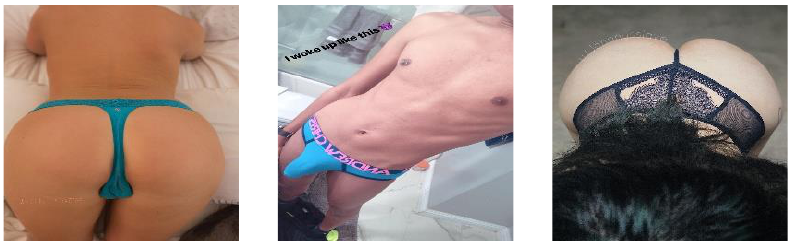
Figure 1. Some example sexy images analogous to our simulated